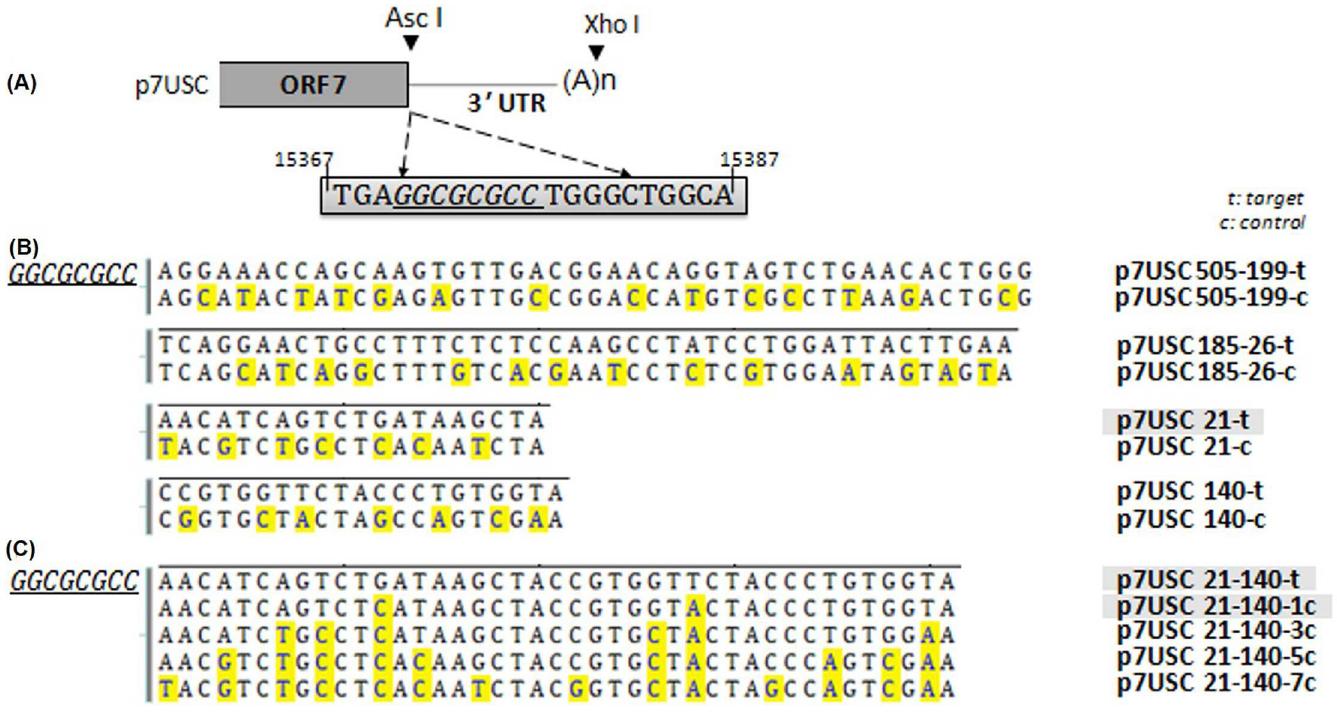
Fig 3. Schematic diagram of PRRSV mutants containing miRNA-target sites. A: Schematic drawing of the insertion sites in the viral genome. The gray box indicates part of the viral genome. p7USC is a full-length infectious cDNA clone containing an Asc I site located after the stop codon of ORF7. B and C: Construction strategy of miRNA-target sites inserted into mutants. Residues in yellow shade indicate the mutated sites as